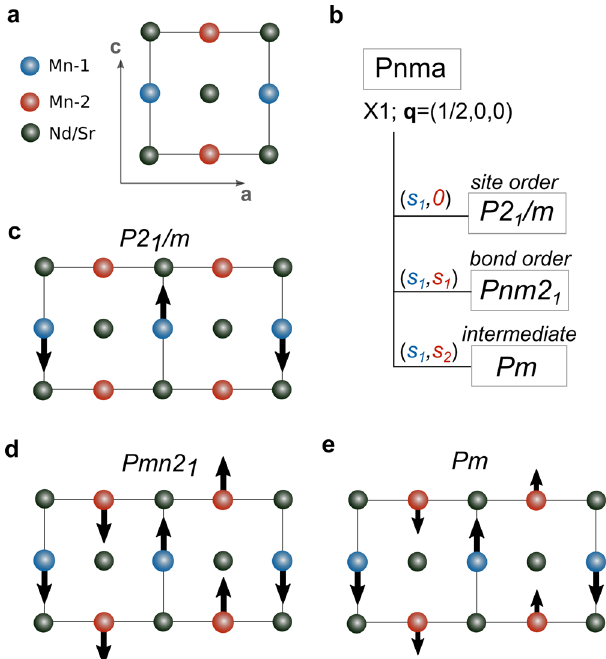
Fig. 2 The symmetry of distorted structures. a High-symmetry unit cell with two Mn sublattices. b Group-subgroup relations for displacements with the wavevector q = (1/2, 0, 0) and irreducible representation X1. The X1 order parameter is two-dimensional with each dimension corresponding to a Mn sublattice. c – e Displacement patterns for the site-centered ( s 1 , s 2 = 0), bond-centered ( s 1 , s 2 = s 1 ), and intermediate ( s 1 , s 2 ≠ s 1 ) phase,